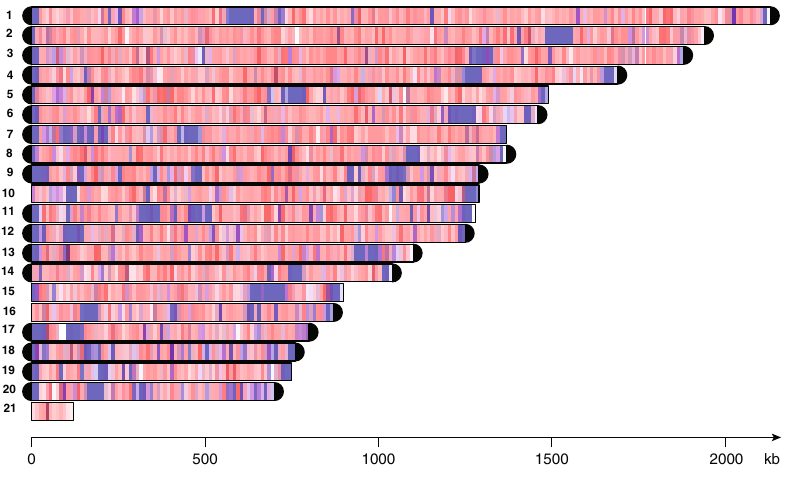
Figure 1. Contigs and telomeres in Plasmodiophora brassicae e3 strain. Contig sizes of the nuclear (no. 1 to 20) and mitochondrial genome (no. 21). Telomeres are marked with black ends. Density of coding (red) and repeat (blue) sequences in non-overlapping sliding 10 kbp windows. The color intensity is proportional to the given feature